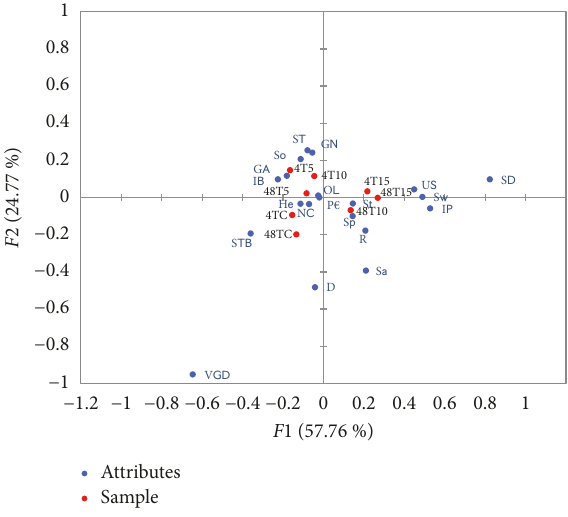
Figure4:Principalcomponentanalysisofbreadattributes.S:sticky; GA: good to accompany; SD: smell of dairy products; VGD: very good for diet; US: unpleasant smell; Sa: salty; D: dry; So: soft; NC: nice colour; ST: soft to touch; H: healthy, IP: innovative product; Sw: sweet; Sp: springy to touch; GN: good for nutrition; STB: smell of traditional bread; R: rubbery; IB: ideal for breakfast; P€: propensity to purchase; OL: overall